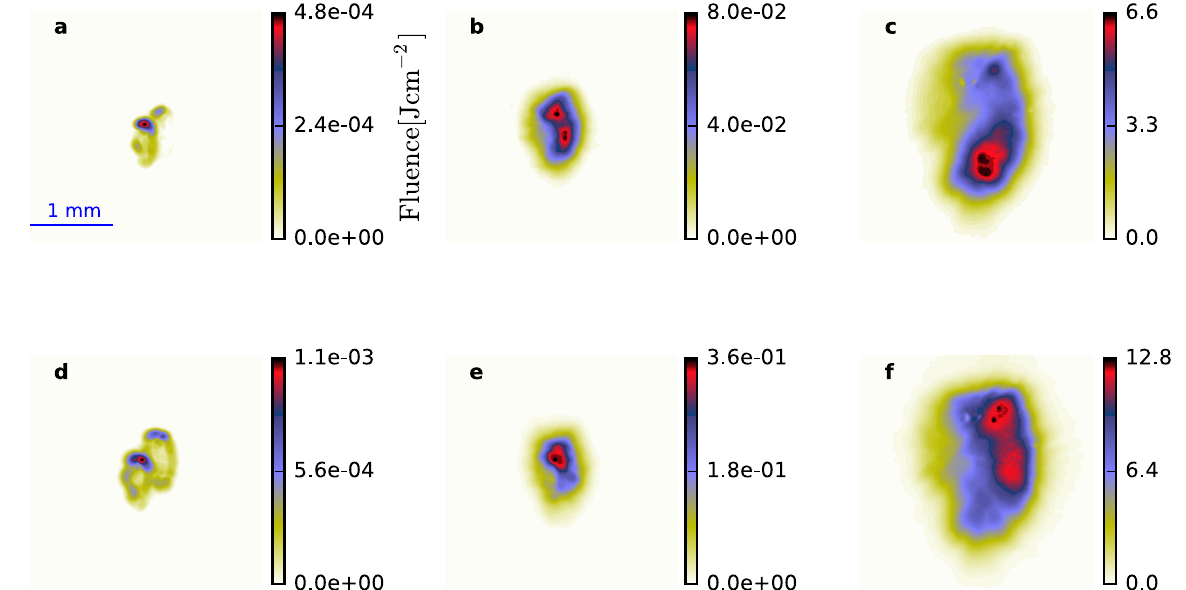
Figure 2. Transverse profile of the Raman signal. Recorded beam profiles for three different nominal pump energies: 3 J ( a , d ), 20 J ( b , e ) and 70 J ( c , f ). ( a–c ) are obtained from amplification from noise, while ( d–f ) are recorded with external seed injection. Note the very different fluence